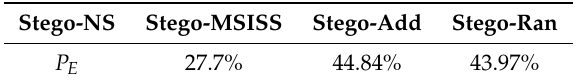
Table 5. The comparison of undetectability possibility results between Stego-NS and other stego images with different embedding contents.